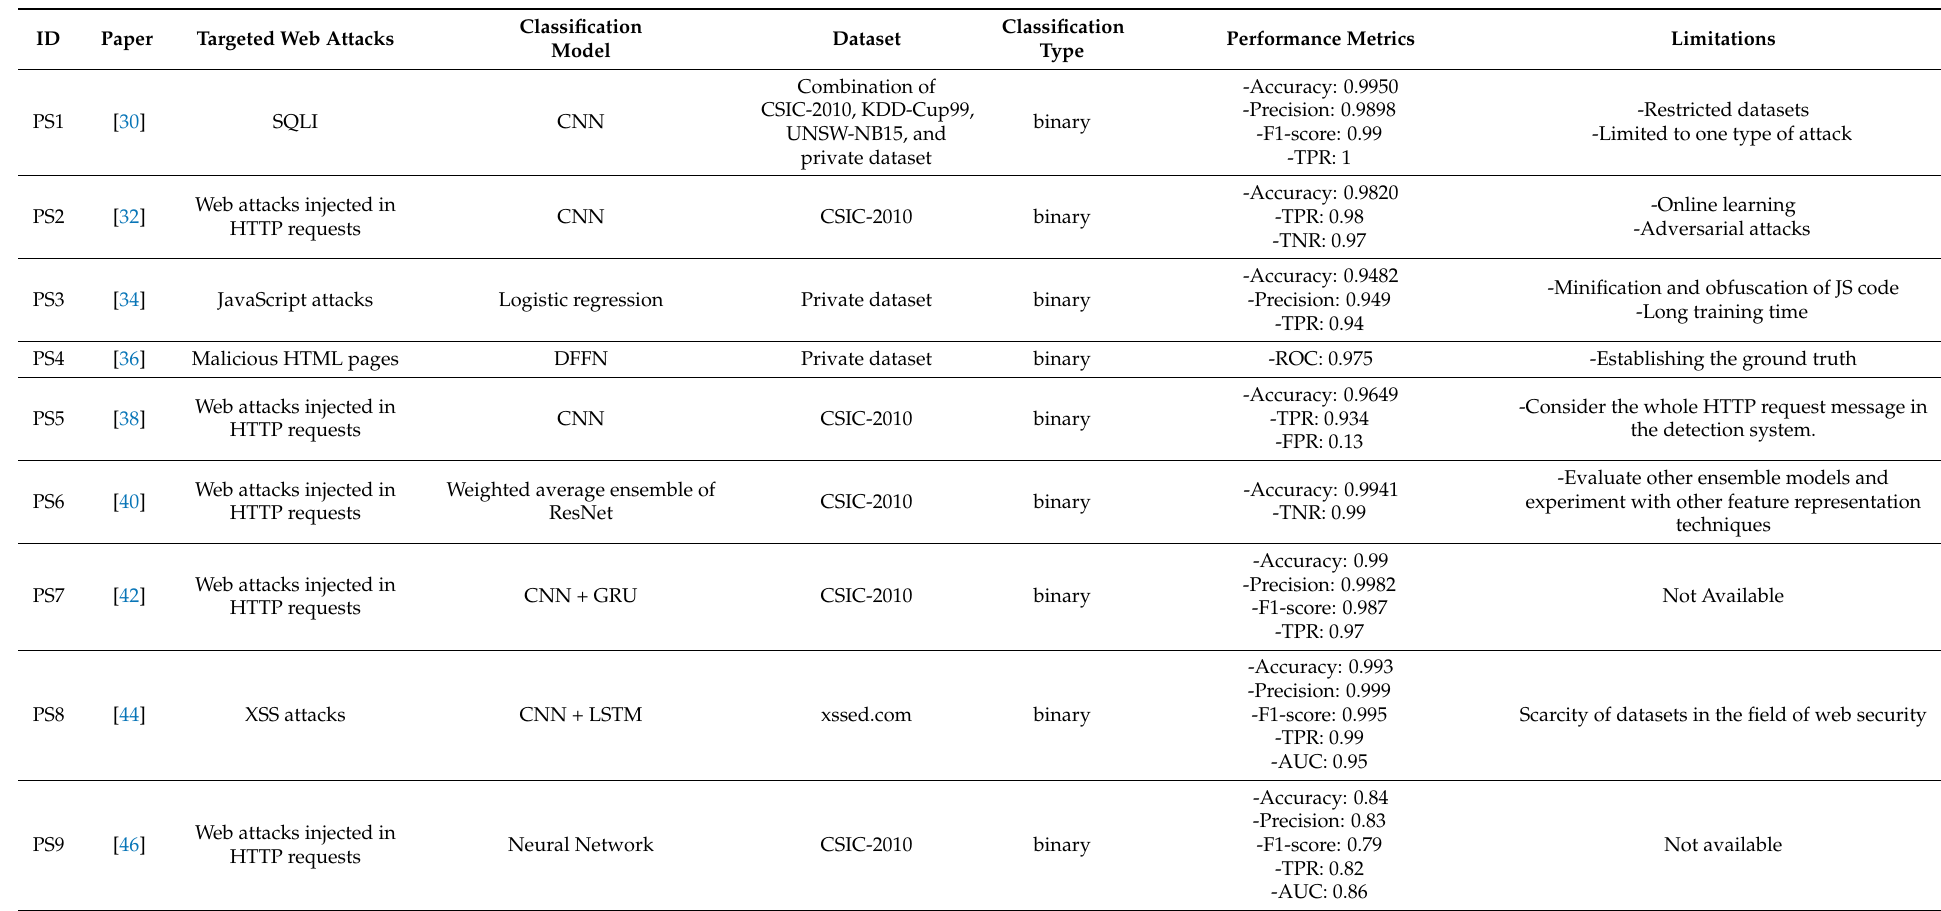
Table 5. A summary of experiments conducted in selected